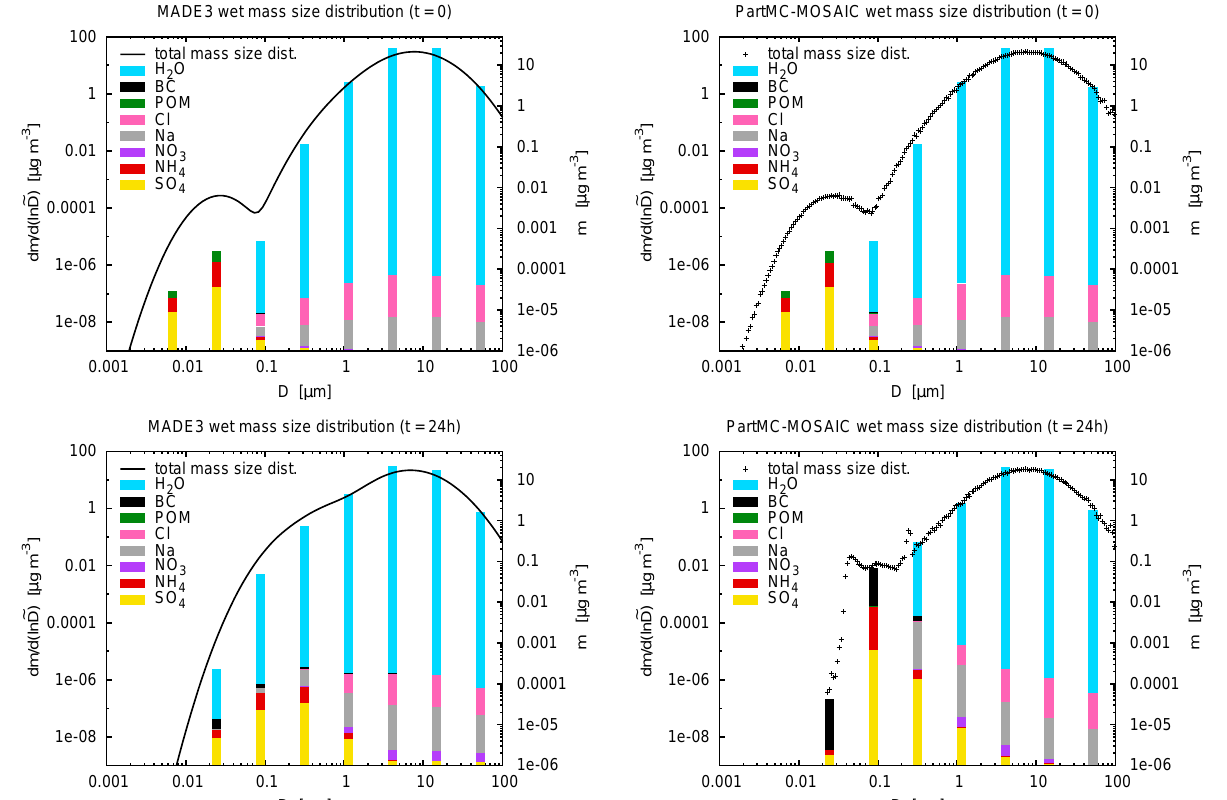
Fig. A1. Aerosol mass size distributions and size-resolved composition at t = 0 (top panels) and t = 24h (bottom panels) for MADE3 (left panels) and PartMC-MOSAIC (right panels). Total mass size distributions are shown in the MADE3 panels as black lines (calculated as the sums over the modes), in the PartMC-MOSAIC panels as black crosses (left vertical axes). The coloured bars show the contributions of the individual species (POM = particulate organic matter, BC = black carbon) to the respective mass concentrations (right vertical axes). In the PartMC-MOSAIC plots particles were binned into size sections, and the bars show the average compositions in these sections. For the MADE3 plots the binned mass concentrations were computed as the sums over the fractions of particles in all modes that fell within the same size sections. Note that while the right vertical axes are logarithmic, the species fractions in the bars add up linearly to the total mass concentrations (i.e. the axes only apply to the total mass concentrations in each bin, but not to the individual contributions).